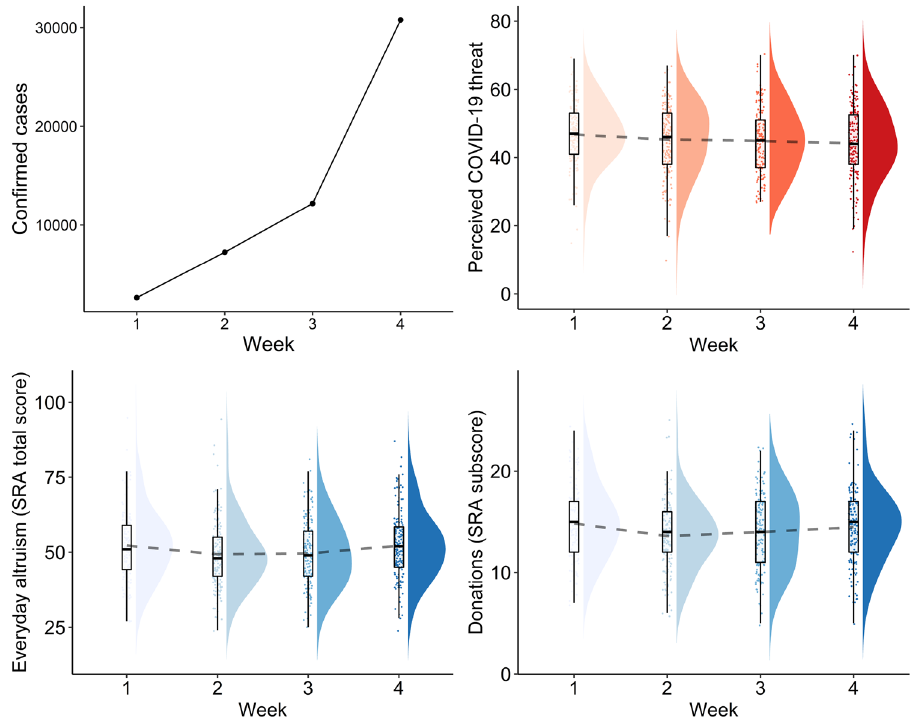
Figure 1. Total number of confirmed cases averaged across states, over the 4 weeks of data collection (top left); Perceived COVID-19 threat over the 4 weeks of data collection (top right ); Everyday altruism over the 4 weeks of data collection (SRA total and donations only score, bottom panel). The dashed line connects the mean across samples (i.e. weeks). Note that the distributions shown here correspond to independent samples collected on each